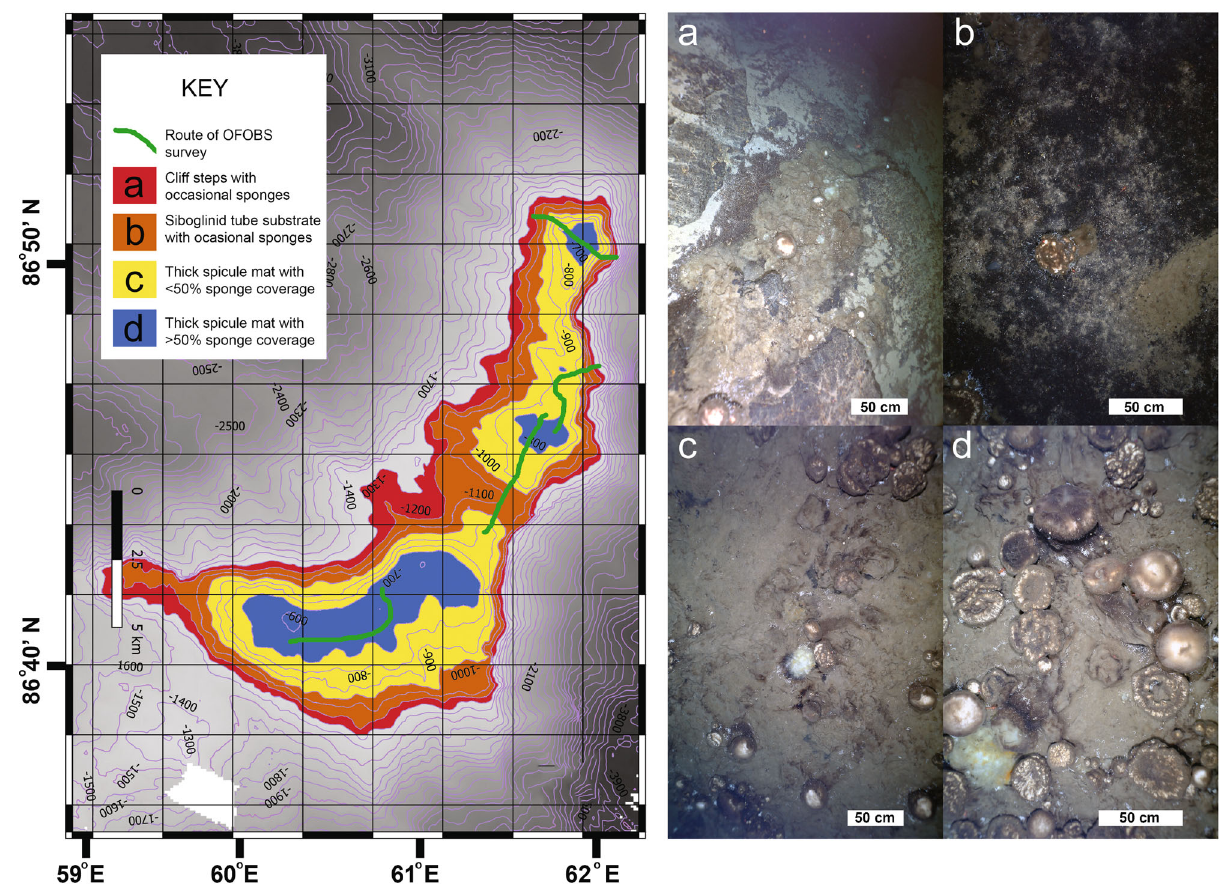
Fig. 2 Sponge density map and representative sea fl oor images. ( Map ) Sponge abundances estimated for different habitat categories: category “ a ” , on fl at shelves on the steep fl anks of the Langseth Ridge (red, occasional concentrations of <100 individuals); category “ b ” , on shallow sloping upper fl anks, with abundant blackened siboglinid tube detritus exposed (orange, average ± SD: 0.8 ± 0.7 ind. m − 2 , 202 ± 195 g C org m − 2 ); category “ c ” , on the fl at summits predominantly covered by sponge spicule-mat with numerous sponges, also present (yellow, average ± SD: 2.8 ± 1.1 ind. m − 2 , 725 ± 217 g C org m − 2 ); and category “ d ” , on the center of fl at seamount peaks (blue, average ± SD: 5.9 ± 1.7 ind. m − 2 , 1702 ± 904 g C org m − 2 ). OFOBS dive tracks are shown in green. (Sea fl oor images a – d ) white scale bars 50 cm length: a Category “ a ” : at the edge of the fl at summit, a rapid increase in slope correlates with a sharp decrease in sponge abundance. Sand and rock outcrops are covered with the siboglinid tube mat. b Category “ b ” : on the more gently shallowing slopes of the mount peaks, dense sponge cover is replaced by occasional individuals on top of the siboglinid tube mat. c Category “ c ” : dense agglomerations of sponges cover the fl at summits, with occasional gaps in sponge spicule cover visible and with 100% tube cover within many of these. d Category “ d ” : in the shallow center of fl at summits, where sponge abundances exceed >50% of sea fl oor coverage. (Photo credits PS101 AWI OFOS